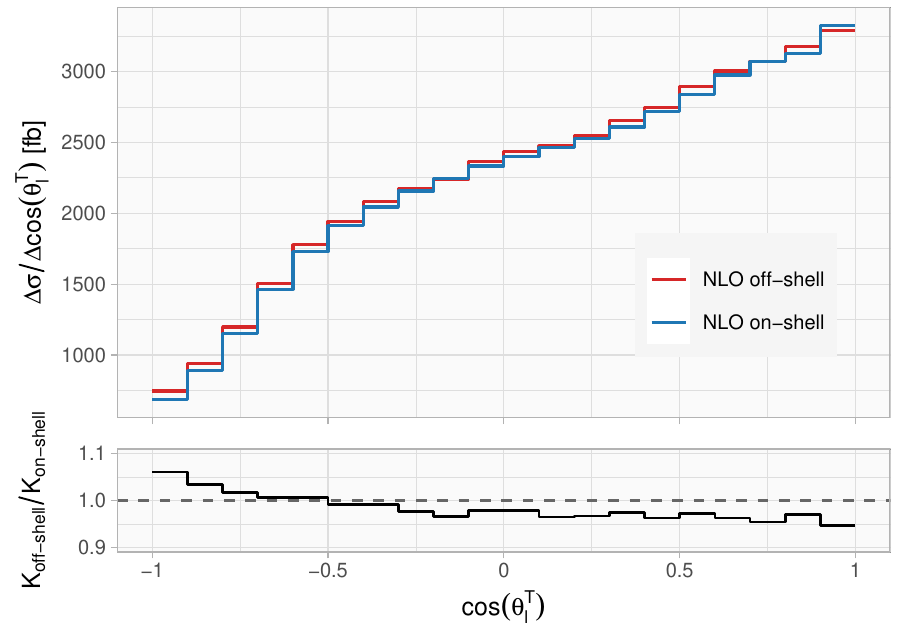
Figure 17. Distribution of cos (cid:18) T at NLO in the on-shell approximation and for an o(cid:11)-shell top l quark. The lower panel shows the ratio of the o(cid:11)-shell and on-shell K -factors. Note the range of the y -axis, which does not start at zero.